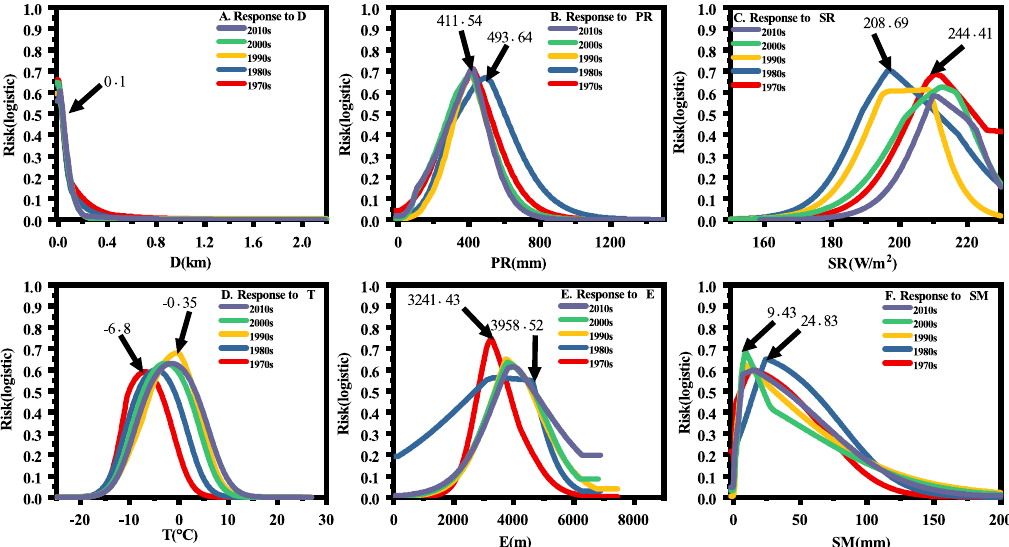
Figure 3. Response curves of environmental variables. The response curves were derived from Maxent runs with variables used in isolation to avoid interference with other variables. They describe how the logistic prediction responds with alteration of each environmental variable. ( A ) The response curves of distance to river in different time; ( B ) The response curves of rainfall in different time; ( C ) The response curves of solar radiation in different time; ( D ) The response curves of temperature in different time; ( E ) The response curves of elevation in different time; ( F ) The response curves of soil moisture in different time.